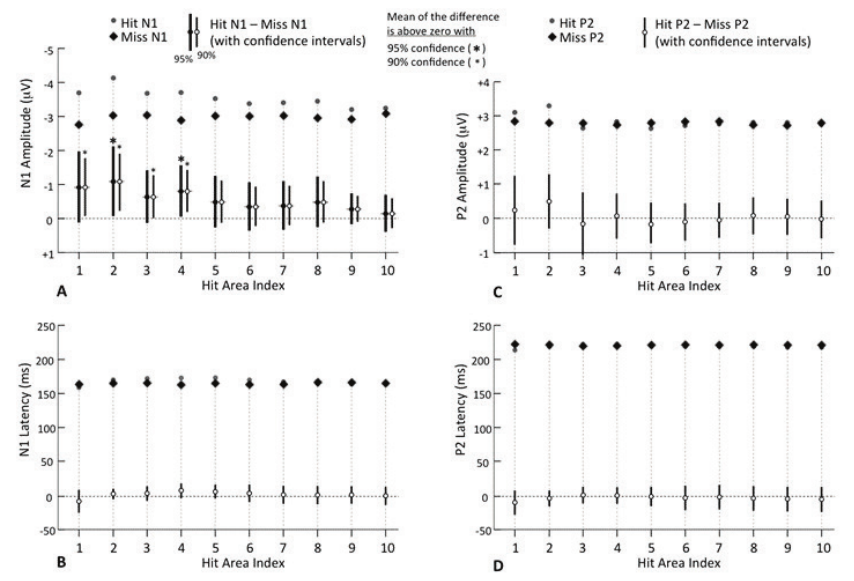
FIGURE 1. Confidence intervals of the N1 amplitudes, N1 latencies, P2 amplitudes and P2 latencies for the ERPs associated with hits and misses. The N1 amplitudes, N1 latencies, P2 amplitudes and P2 latencies for the ERPs associated with hits and misses are given as the difference between these means for each of the area indexes shown by empty circles with confidence intervals around them. Hit area indices increase as the hit area is enlarged from centre to outer surface of the target. The differences of the means are shown with the 95% and 90% confidence intervals for each index and ERP component.